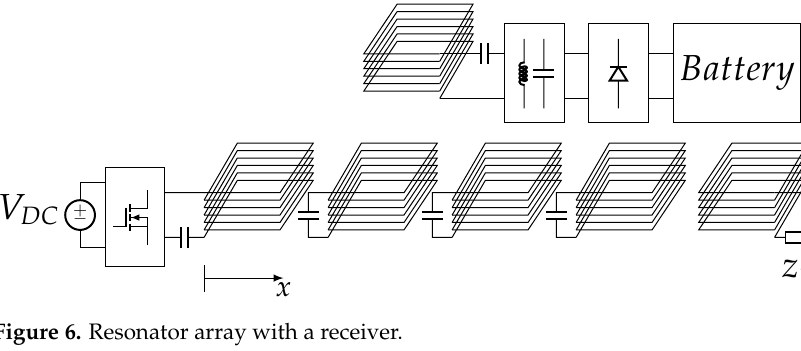
Figure 6. Resonator array with a receiver.